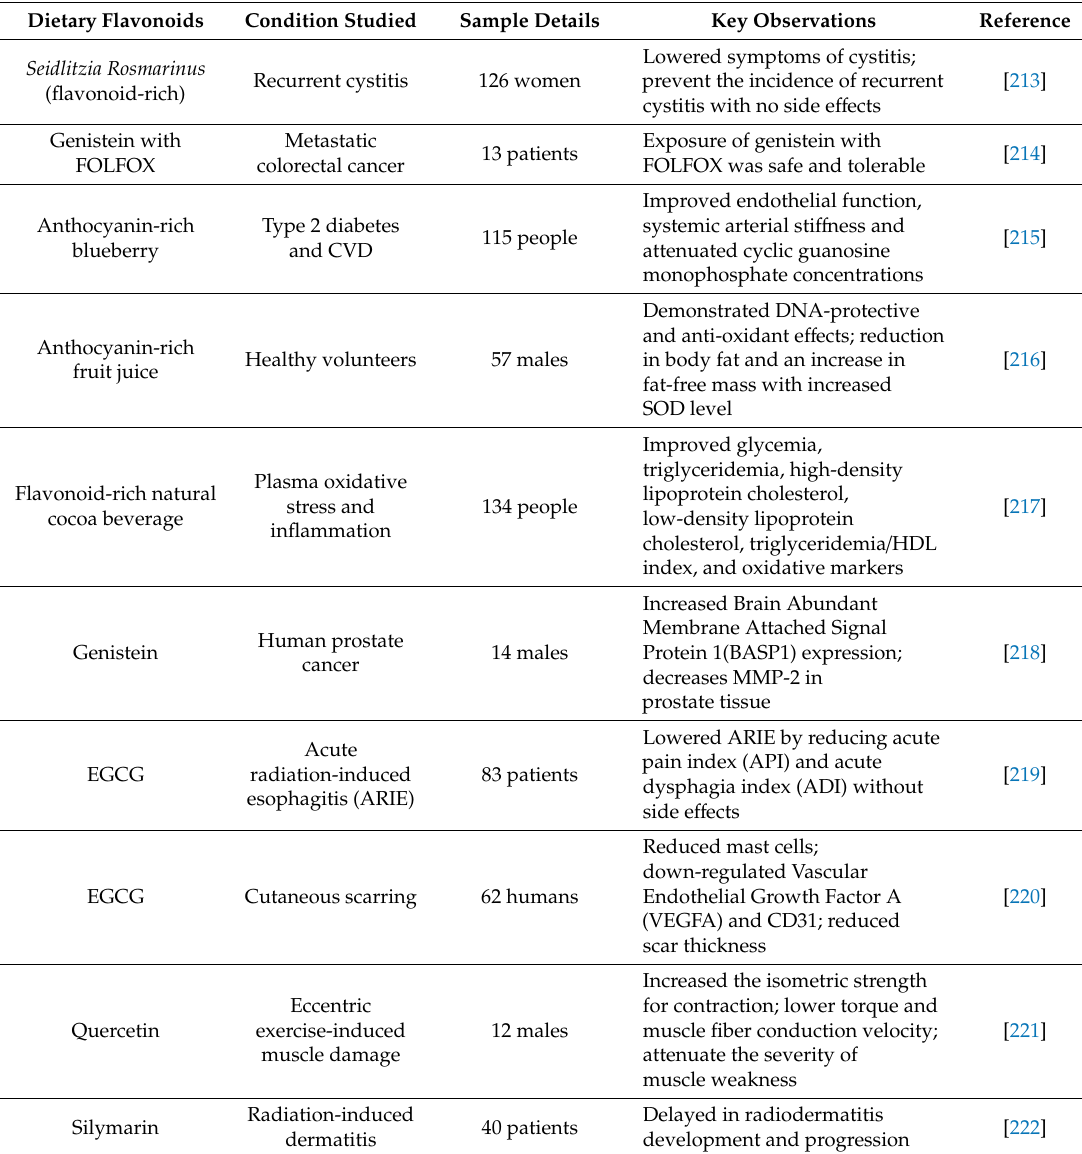
Table 2. Flavonoids-rich diet in disease prevention: a summary from recent (2019–2020) clinical trials. Dietary